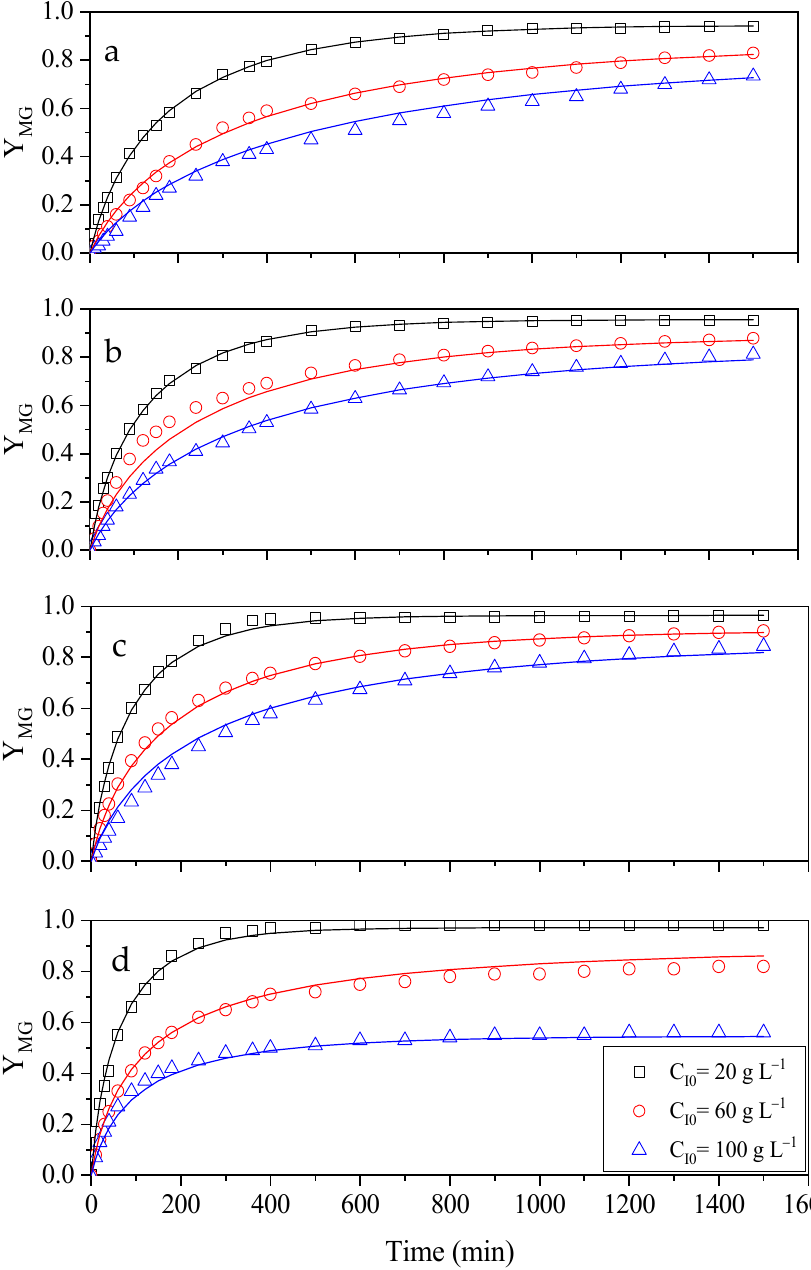
Figure 9. Esterification of ibuprofen and glycerol in reactive L-L-S triphasic systems without water at zero time: Model 2 multivariable fit to all relevant kinetic data: ( a ) 50 °C, ( b ) 60 °C, ( c ) 70 °C and ( d ) 80 °C.